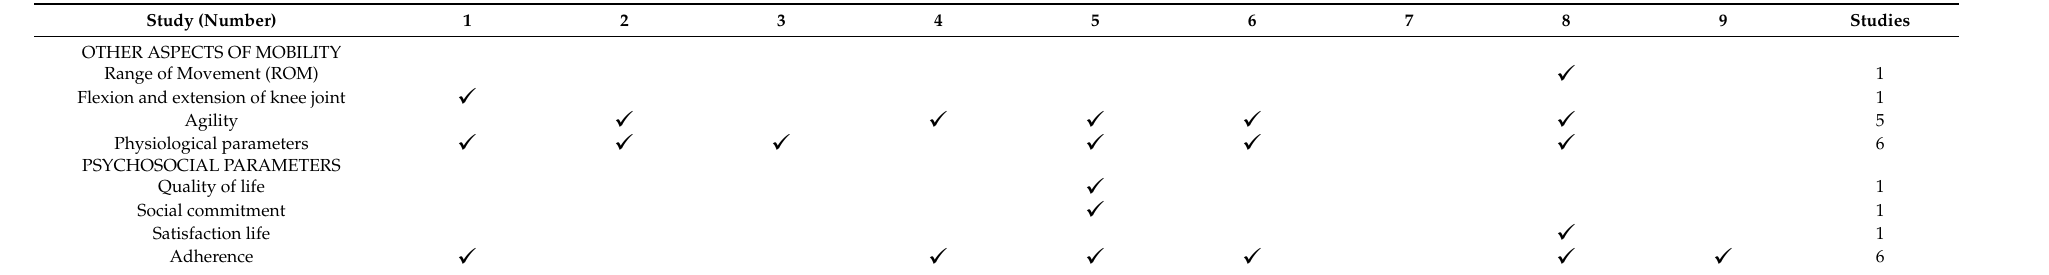
Table 3. Other variables related to mobility and secondary aspects of the psycho-social field were evaluated in the included articles. Study (Number)